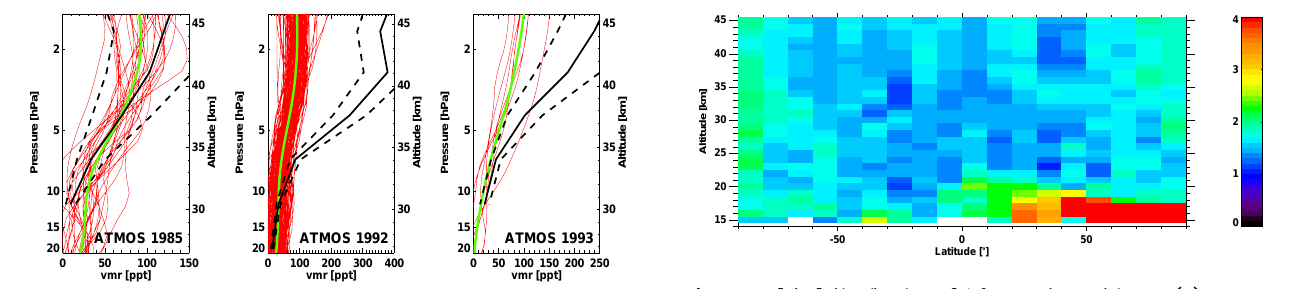
Fig. 9. Comparison of MIPAS observations (2003–2012) of SO 2 (red: single; green: mean) with profiles derived from the ATMOS in- strument (black) (Rinsland et al., 1995). Left: SPACELAB 3, April– May 1985, 26 ◦ N–32 ◦ N vs. MIPAS, April–May 20 ◦ N–40 ◦ N. Middle: ATLAS 1, March–April 1992, 54 ◦ S–28 ◦ N vs. MIPAS, March–April 60 ◦ S–30 ◦ N. Right: ATLAS 2, April 1993, 51 ◦ S– 44 ◦ S vs. MIPAS, April 50 ◦ S–40 ◦ S.